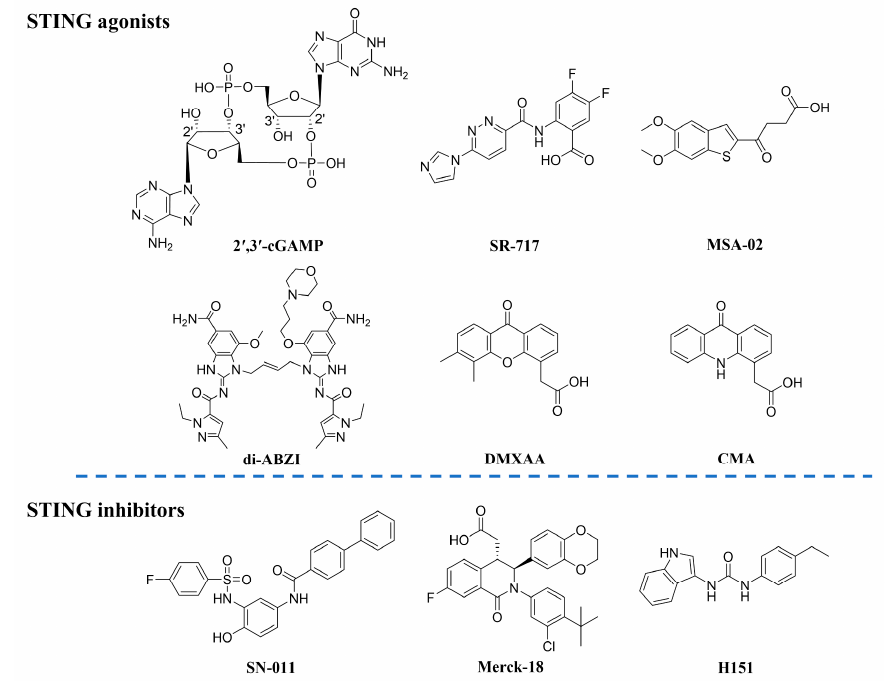
Figure 1. Representative STING modulators.